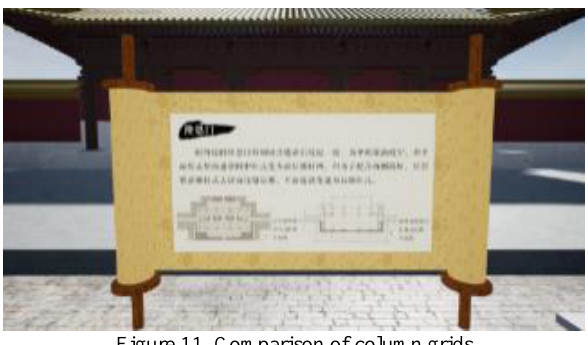
Figure 11. Comparison of column